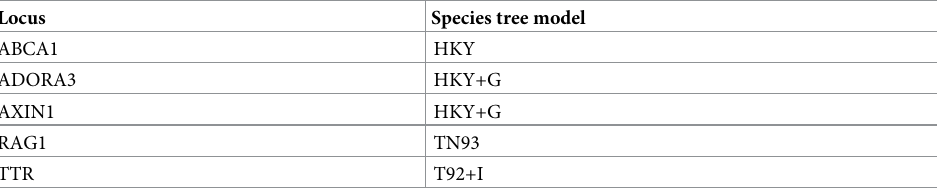
Table 1. Proposed best-fit substitution models for each genetic marker based on Akaike’s information criterion corrected for small sample sizes (AICc) using MEGA7. Locus ABCA1 HKY ADORA3 HKY+G AXIN1 HKY+G RAG1 TN93 TTR T92+I (HKY: Hasegawa, Kishino and Yano model (Hasegawa et al., 1985), TN93: Tamura-Nei two parameter model (Tamura and Nei, 1993); T92: Tamura 3-parameter (Tamura, 1992); I: Invariable sites model; G: Discrete Gamma